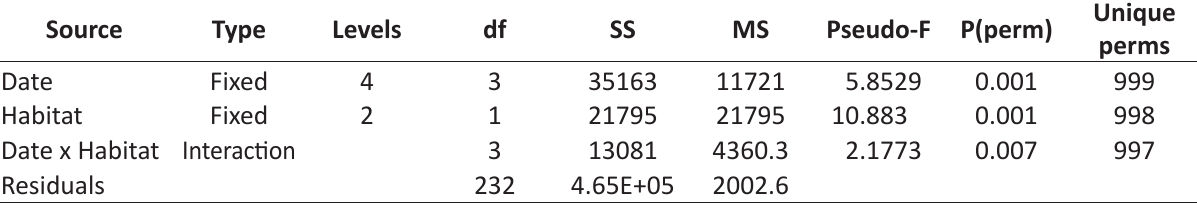
Table 1. PERMANOVA results for all surveys of Exaiptasia pallida and native species abundance in Jellyfish Lake, with date, habitat (mangrove roots and ONS) and their interaction as fixed factors. Differences between dates indicate that percent cover of species changed through time, and differences between habitats indicate that different assemblages are found on the different habitats.